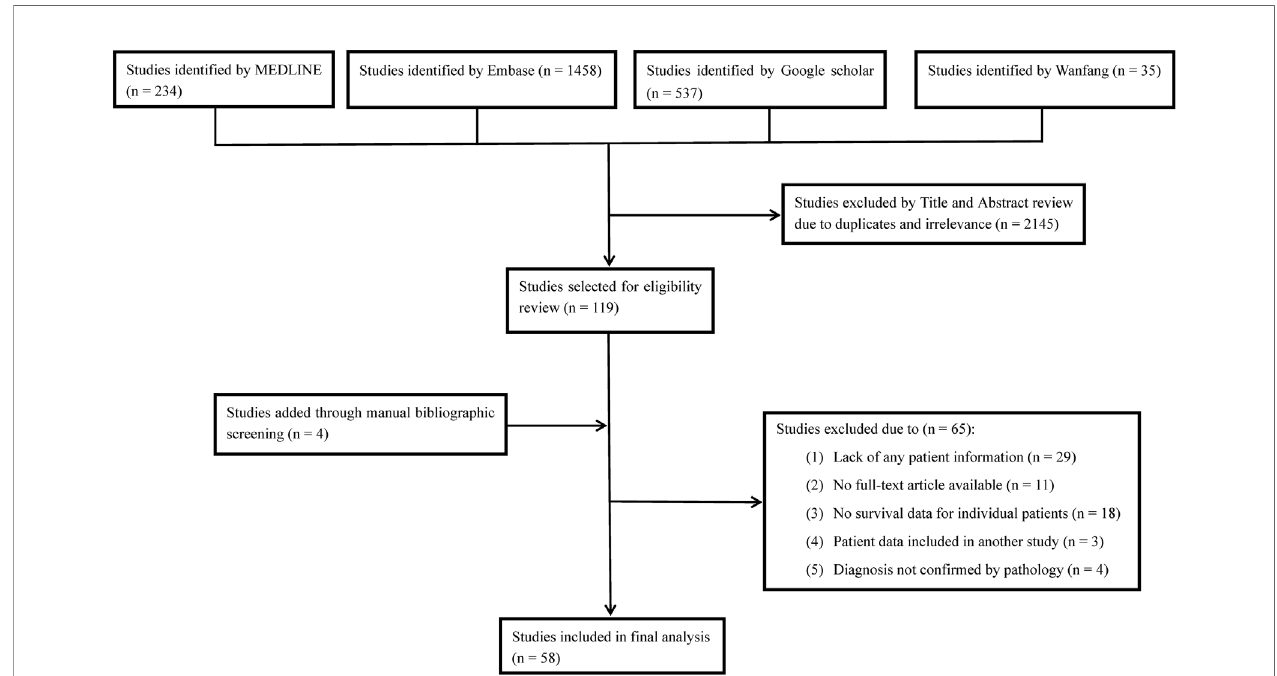
FIGURE 1 | Flow diagram of literature search showing studies identi fi ed, included and excluded at each